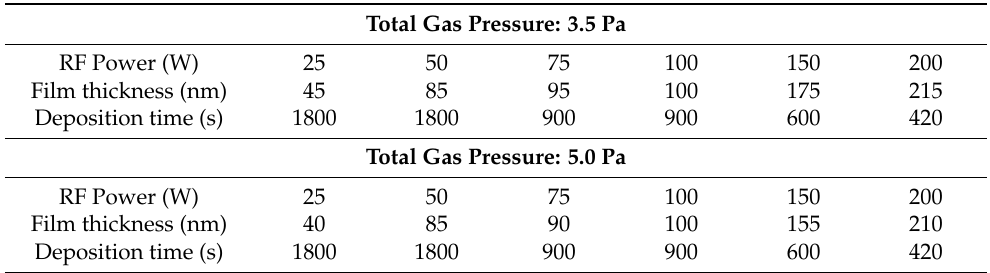
Table 1. Sputtering deposition conditions used to fabricate the Cu 3 N films at RT in N 2 pure atmo- sphere at different RF powers and gas pressures. Film thickness is also